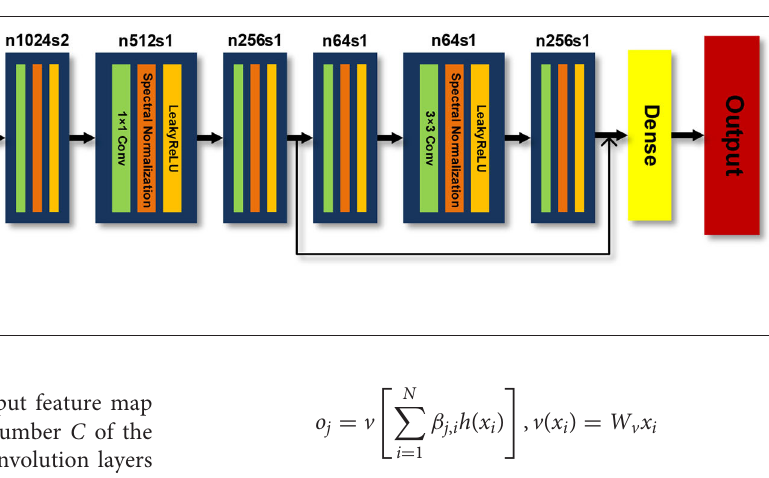
FIGURE 2 | The generator model.